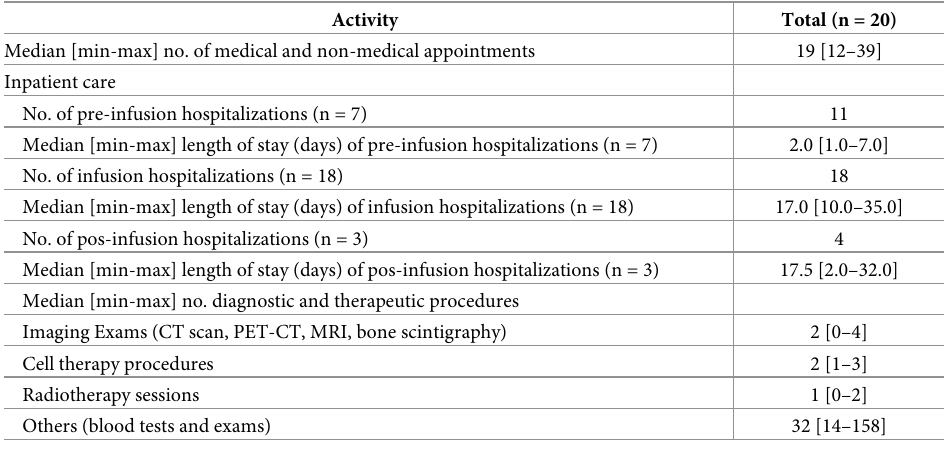
Table 4. Healthcare resources utilization.